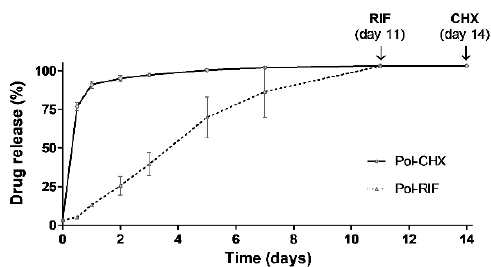
Figure 3. Release profile of CHX and RIF from the chitosan–PLGA nanoparticles polymeric coating over time, following its hydration in PBS ( n = 3 each). Maximum cumulative release was observed after 11 and 14 days for RIF and CHX, respectively.